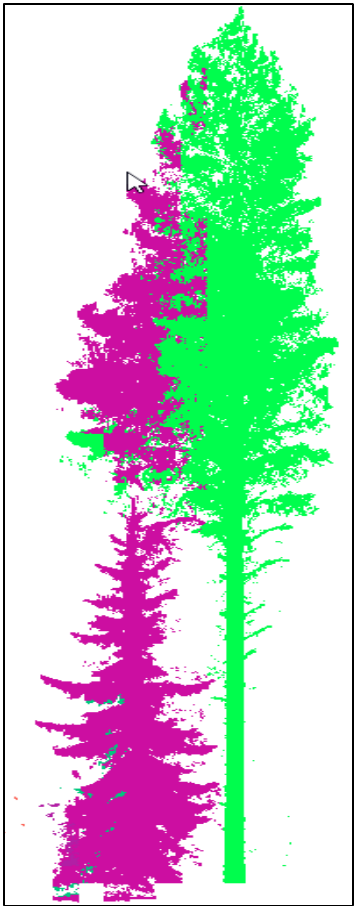
Figure 7. The ‘greedy tree’ artifact. The taller tree is segmented incorrectly because the shorter tree provides a route to the ground for the taller tree’s left side that does not pass through the taller tree’s